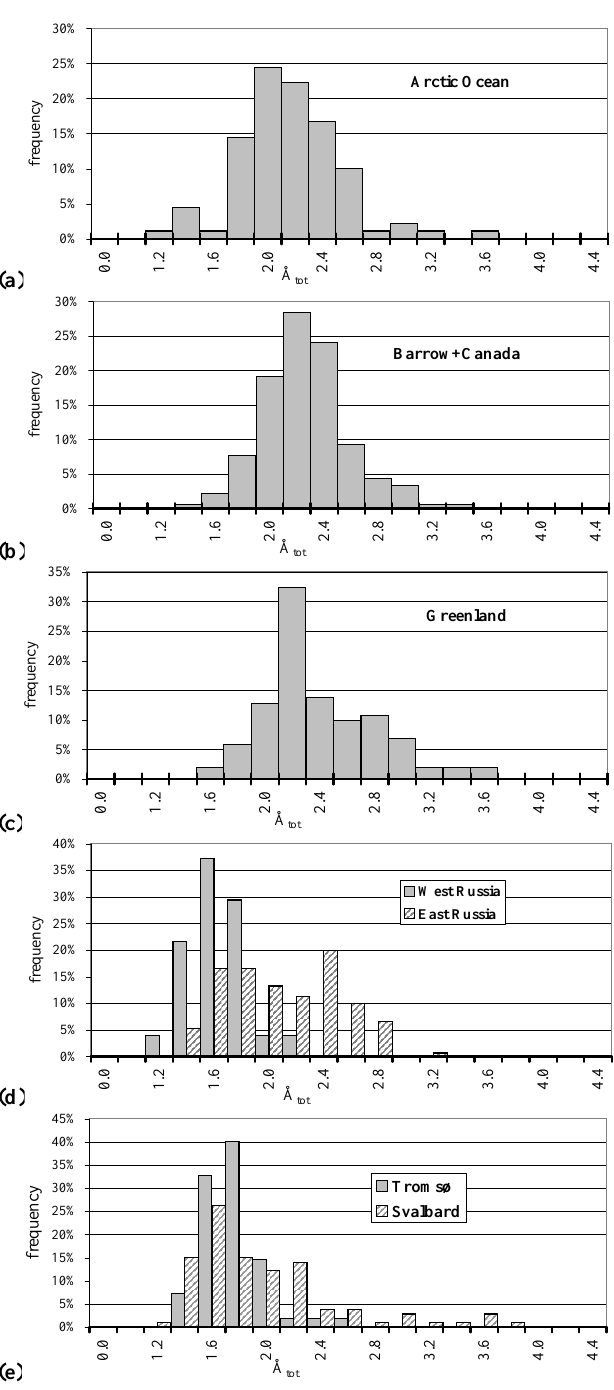
Fig. 7. Histograms of the frequency of occurrence of the absorption ˚Angstrom exponent ˚A tot (450–600nm) within different sampling re- gions. Samples from all snow depths are